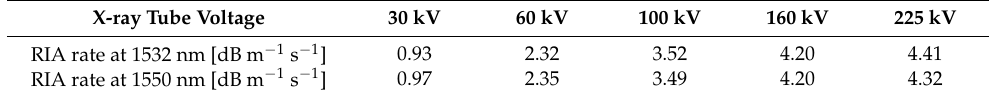
Table 4. Experimental RIA rates of OF samples at 1532 nm and 1550 nm over the first 100 s of irradiation, for investigated X-ray tube voltages. Uncertainty is estimated to be less than ±